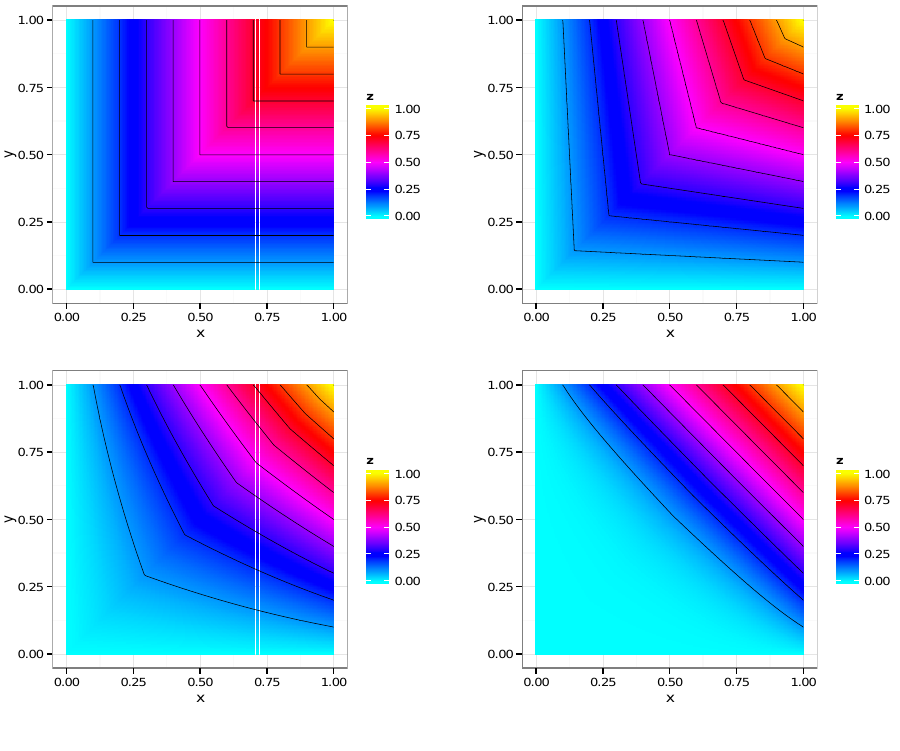
Figure 2: Image plot of T n